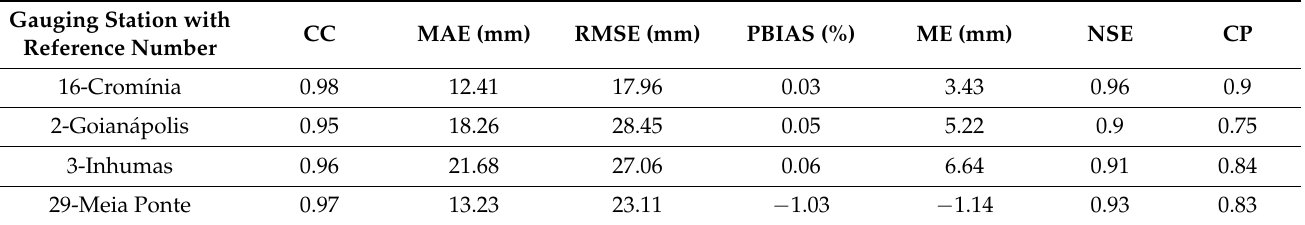
Figure 5. Monthly rainfall amounts as obtained from the GPM product and ground-based gauges for the Meia Ponte River catchment. Table 7. Goodness-of-fit metrics for monthly precipitation data from four gauging stations located in the Meia Ponte River catchment.